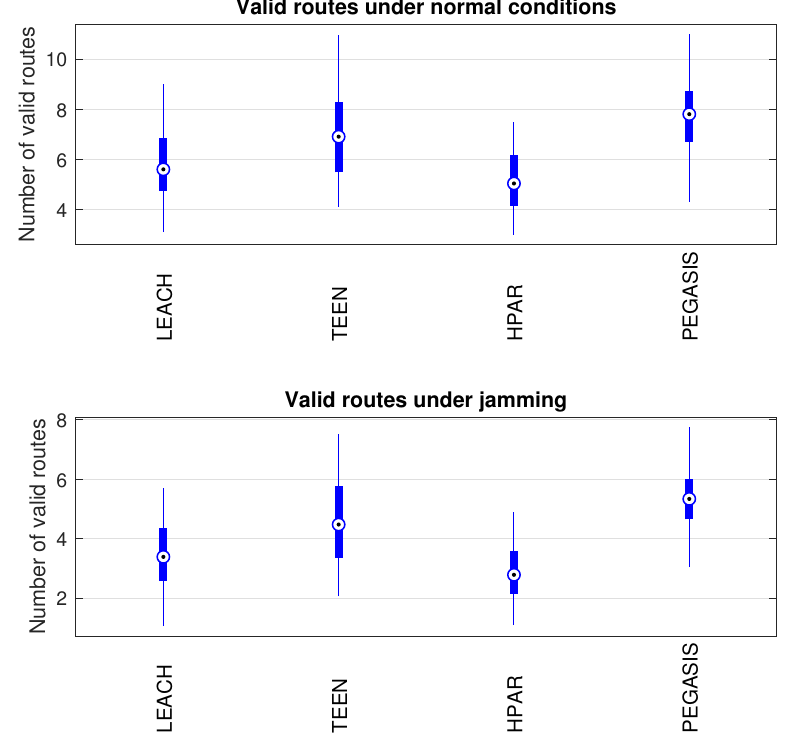
Figure 14. Routing tables’ conditions under normal conditions and jamming.